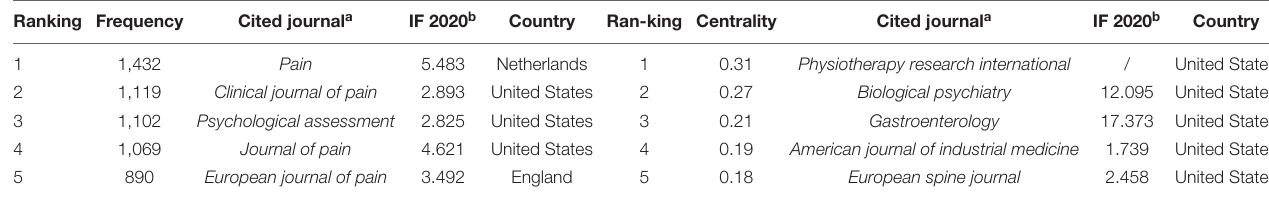
Frontiers in Psychology |